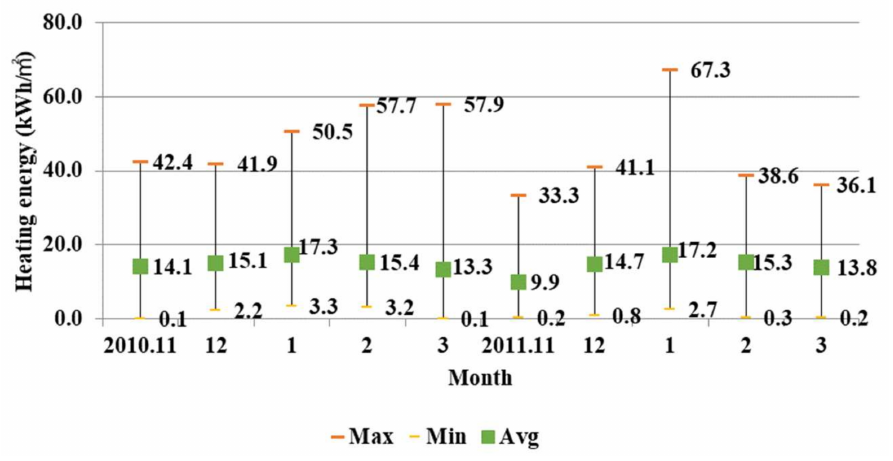
Figure 6. Maximum and minimum values of monthly heating energy from households sized 35 m 2